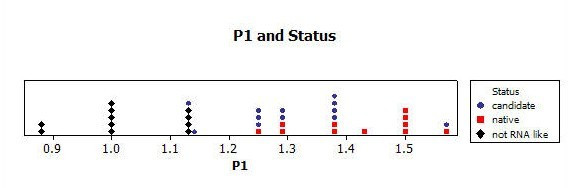
Dot plot for P1.